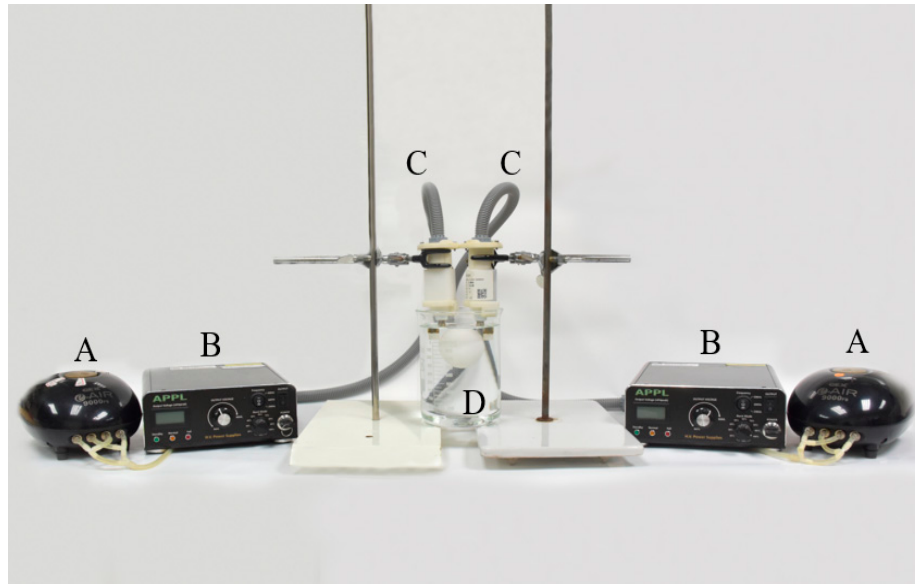
Figure 1. The devices of the air plasma-activated water system, including ( A ) air pumps, ( B ) high- Figure1. Thedevicesoftheairplasma-activatedwatersystem, including( A )airpumps, ( B )high-voltage voltage power supply, ( C ) plasma jet generators, and ( D ) the beaker containing one egg. power supply, ( C ) plasma jet generators, and ( D ) the beaker containing one